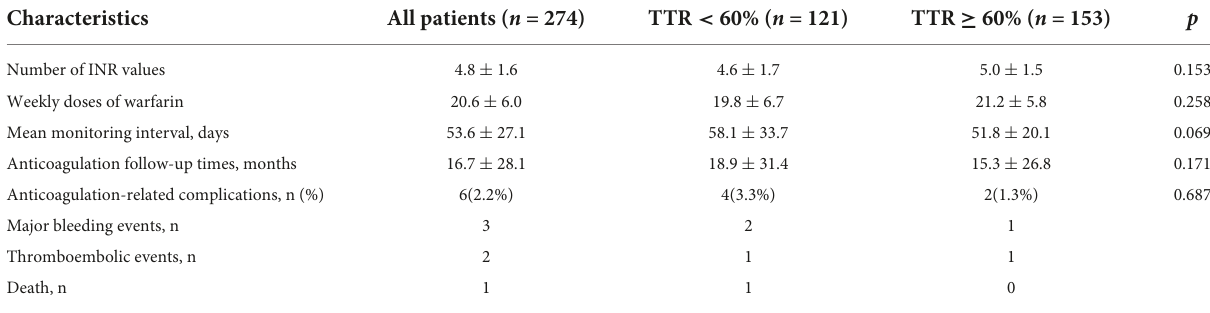
TABLE 5 Characteristics of warfarin treatment during the